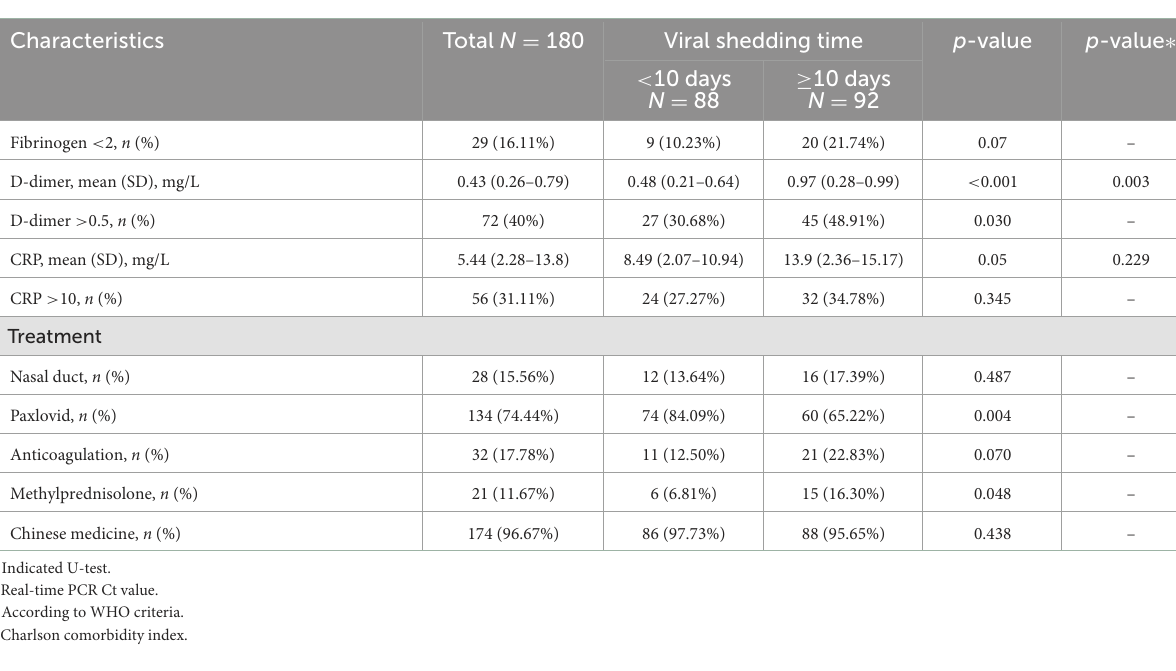
TABLE 2 Multivariable analyses of factors associated with duration of viral shedding time.